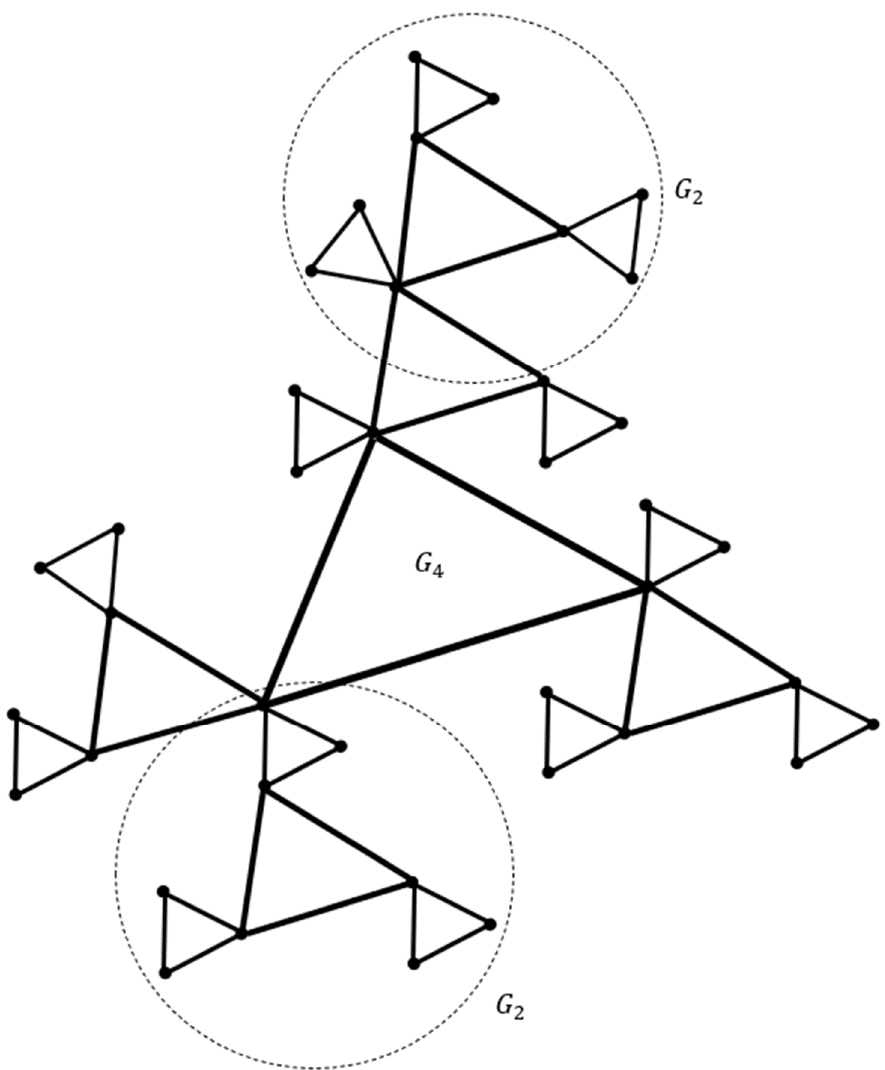
Figure 5. Noncanonical prefractal graph G 4 generated with G 2 .